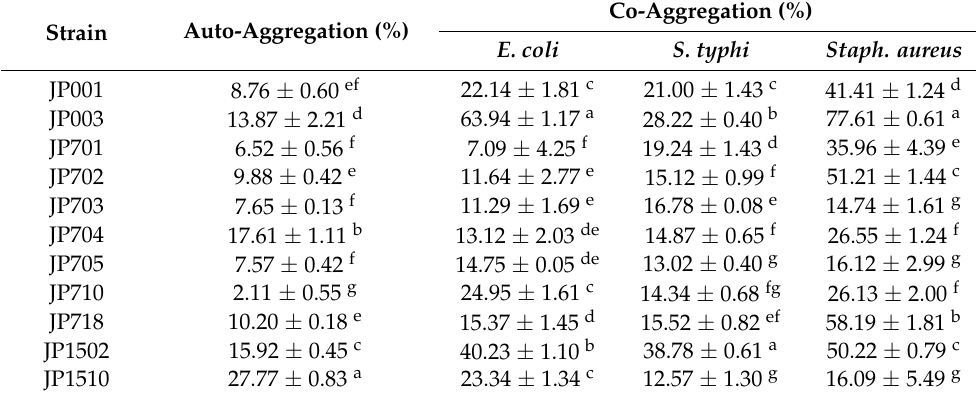
Table 4. Auto-aggregation (%) and Co-aggregation (%) of LAB strains.